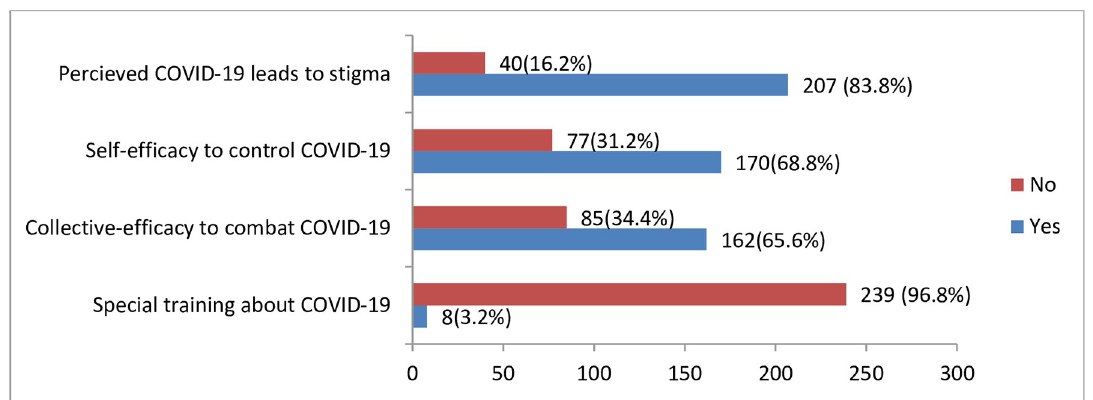
Fig 3. Bar graph including experience of training session and perceived stigma and efficacy to combat COVID-19, JMC visitors, Jimma-Ethiopia, March, 2020.